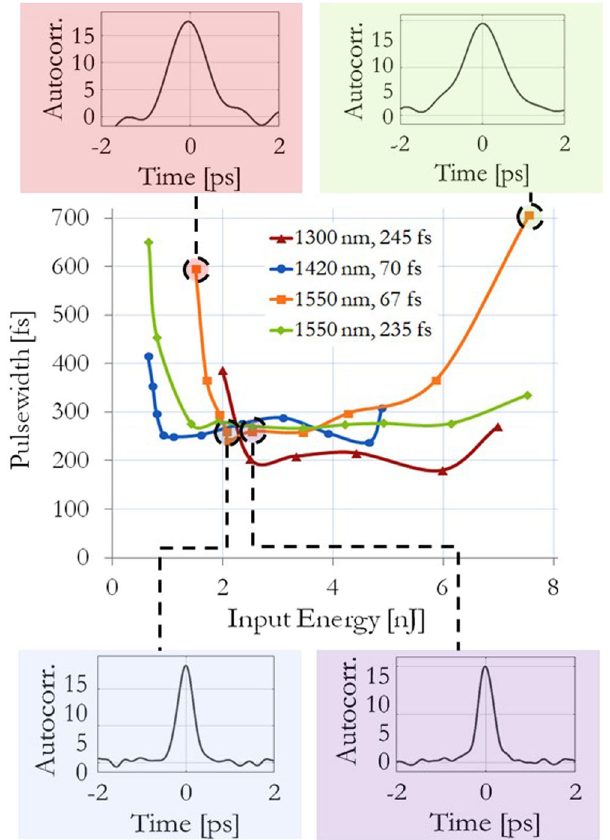
Fig. 1 Measured soliton pulsewidth vs. input pulse energy, after 120 m of graded-index (GRIN) fi ber, for different input wavelengths and pulse durations. The insets are the measured output autocorrelation traces, for an input wavelength 1550 nm and pulsewidth 67 fs. Measurement error comes directly from the instrument accuracy, that is below 1%, i.e., too small to be visible at this